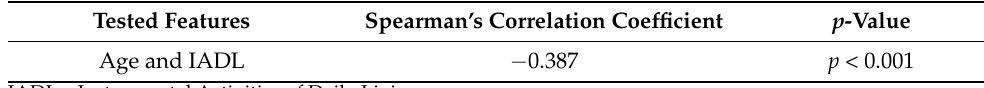
Table 5. Influence of age on the IADL result. Tested